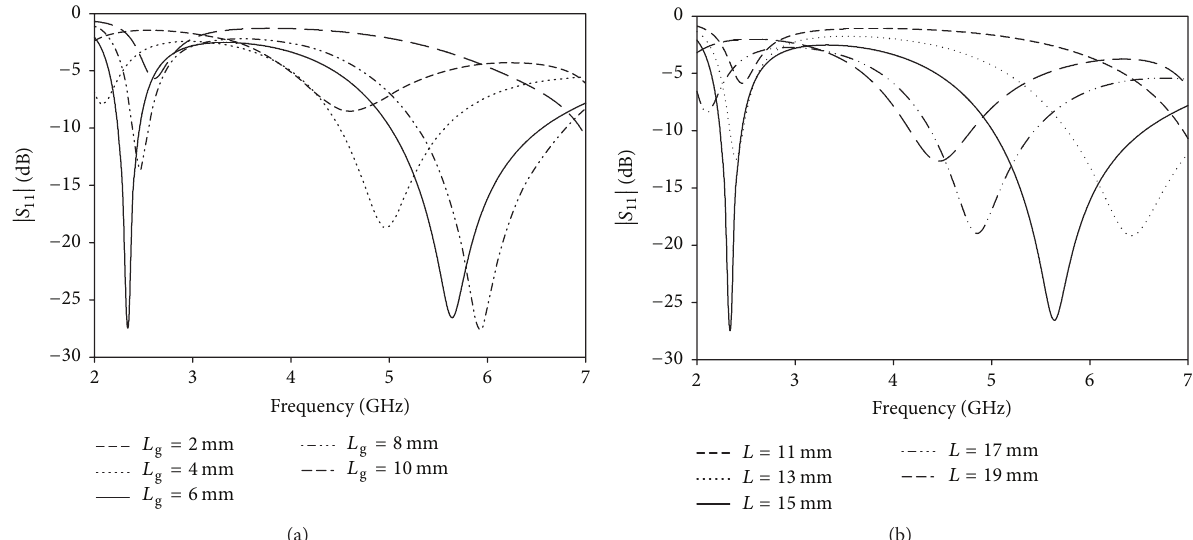
Figure 4: (a) The effects of varying length 𝐿 on the reflection coefficient of the proposed antenna. Other parameters are the same as those g listed in Table 1. (b) The effects of varying length 𝐿 on the reflection coefficient of the proposed antenna. Other parameters are the same as those listed in Table 1.